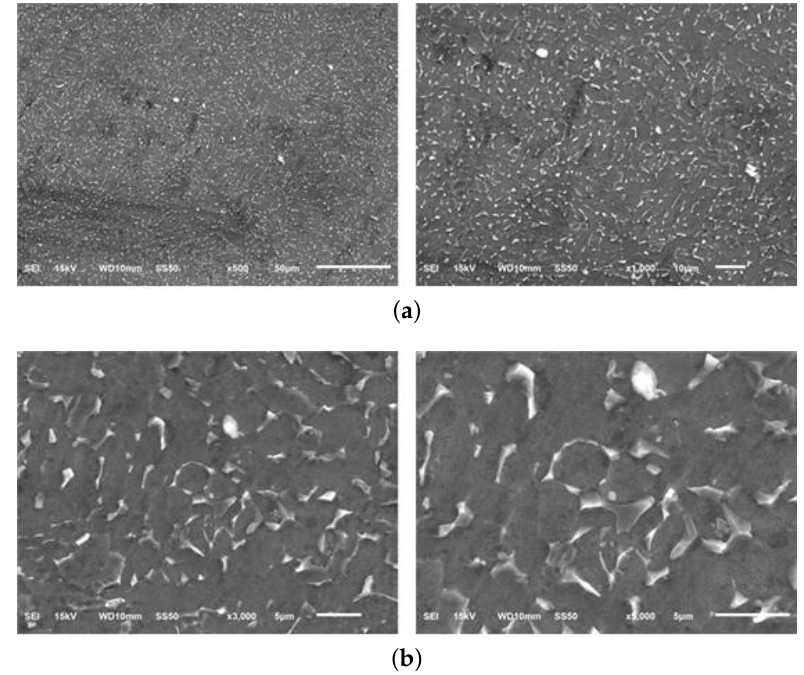
Figure 12. Microstructure of Material sample A–Scanning Electron microscopy (SEM). ( a ) Material sample A (500 and 1000 × ); ( b ) Material sample A (3000 and 5000 × ).